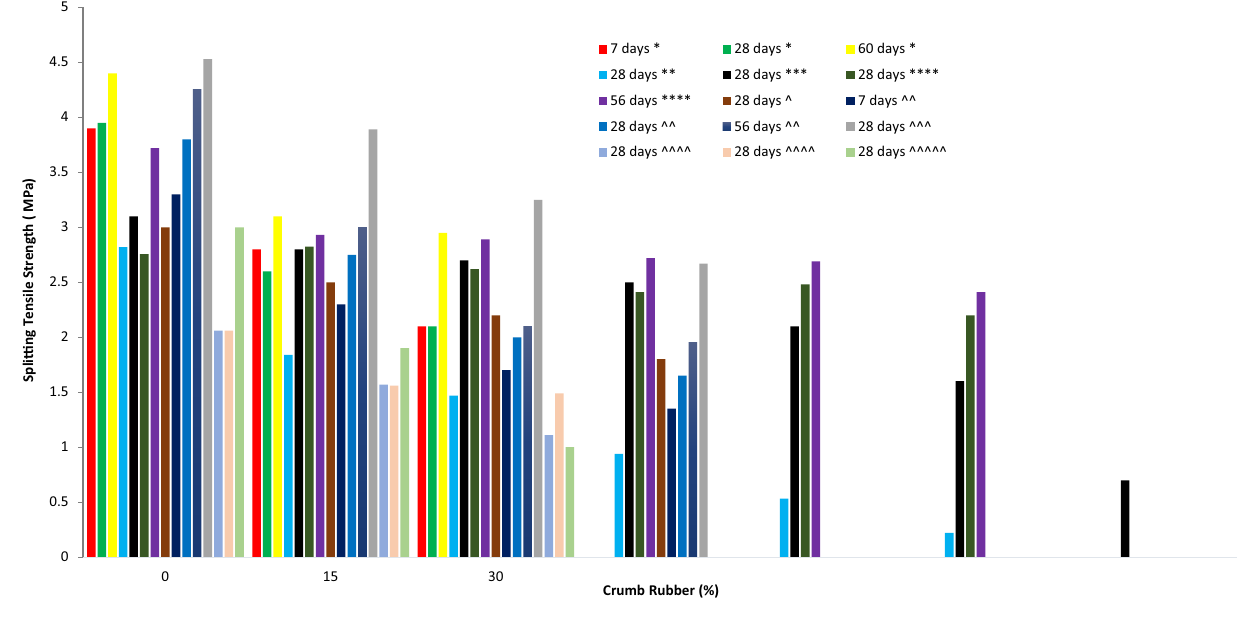
Fig. 13 Crumb Rubbercrete split tensile strength. *[29], ^[38], ^^^^^[137, **[110], ^^[112], ***[20], ^^^[9], ****[31], ^^^^[114]